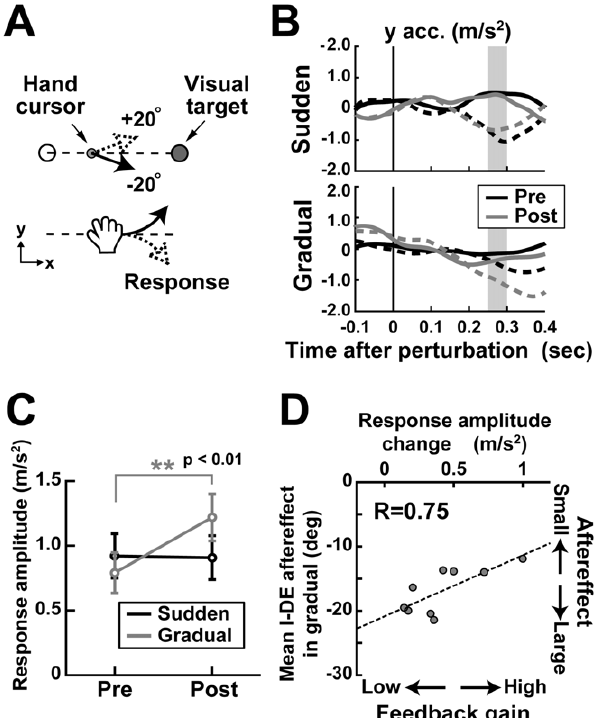
Figure 4. Cursor perturbation effects. A , Cursor perturbation. The cursor movement direction relative to the hand movement direction was suddenly shifted 6 20 u from 150 ms after the cursor was turned on. B , Averaged acceleration patterns in the y -direction for the negative (solid) and positive (dashed) direction perturbations. Time zero corresponds to the onset of the cursor perturbation. C , Mean amplitude of acceleration response across subjects. Error bars denote the SE. The response amplitude was calculated from the temporal average of the y - acceleration difference between the perturbation directions for the interval of 250–300 ms from the perturbation onset (shaded areas in B). The double asterisks denote the significance of differences ( p , 0.01). D , The relationship between the I-DE aftereffect and the response amplitude change in individual subjects in the gradual condition. The I-DE was averaged from 41 st to 46 th blocks for each subject. The negative I-DE indicates a large aftereffect. The positive value of response amplitude change indicates the increase in the response amplitude to the cursor perturbation after the training, which corresponds to the increase in the feedback gain due to the learning of the gradual visuomotor rotation.